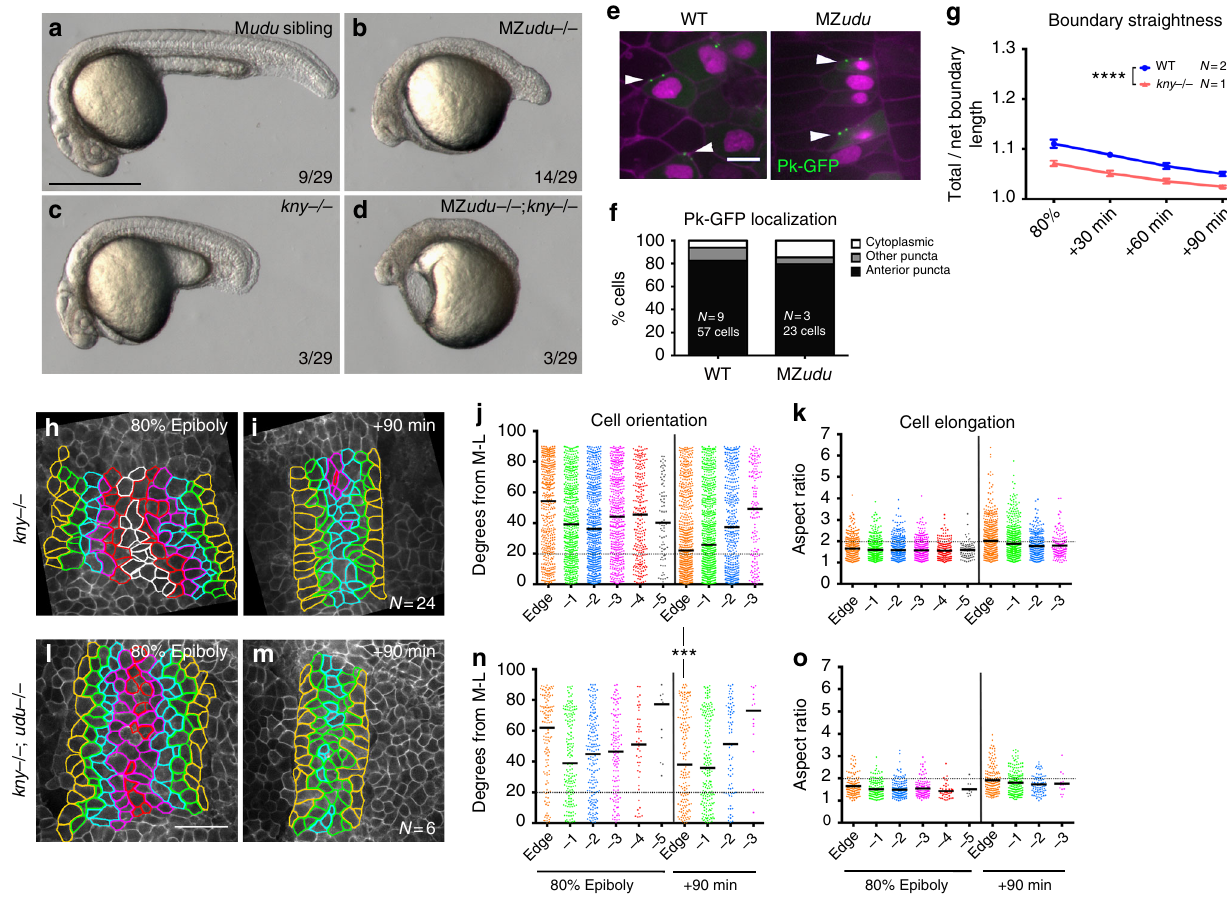
Fig. 4 Gon4l regulates axis extension independent of PCP signaling. a – d Live embryos at 24 hpf resulting from a cross between a germline-replaced udu − / − ;kny fr6/ + female and an udu + /-;kny fr6/ + male. Genotypes are indicated in the upper right corner, fractions indicate the number of embryos in the clutch with the pictured phenotype. e Mosaically expressed Prickle (Pk)-GFP in WT and MZ udu − / − gastrulae. Arrowheads indicate anteriorly localized Pk- GFP puncta. Membrane Cherry marks cell membranes, nuclear-RFP marks cells injected with pk-gfp RNA. Images are representative of three independent experiments. f Quanti fi cation of Pk-GFP localization shown in e (chi-square, p = 0.07). g Quanti fi cation of notochord boundary straightness in WT and kny − / − gastrulae. Symbols are means with SEM (two-way ANOVA, **** p < 0.0001). h , i , l , m Still images from live time-lapse confocal movies of the axial mesoderm in kny − / − ( h – i ) and kny − / − ;udu − / − ( l – m ) gastrulae at the time points indicated. Cell outlines are colored as in Fig. 3. j , n Quanti fi cation of axial mesoderm cell orientation as in Fig. 3, bars are median values (Kolmogorov – Smirnov test, *** p = 0.0003). k , o Quanti fi cation of axial mesoderm cell elongation as in Fig. 3, bars are mean values. N indicates number of embryos analyzed (and number of cells in f ). Scale bar is 500 μ m in a – d , 10 μ m in e , 50 μ m in h –